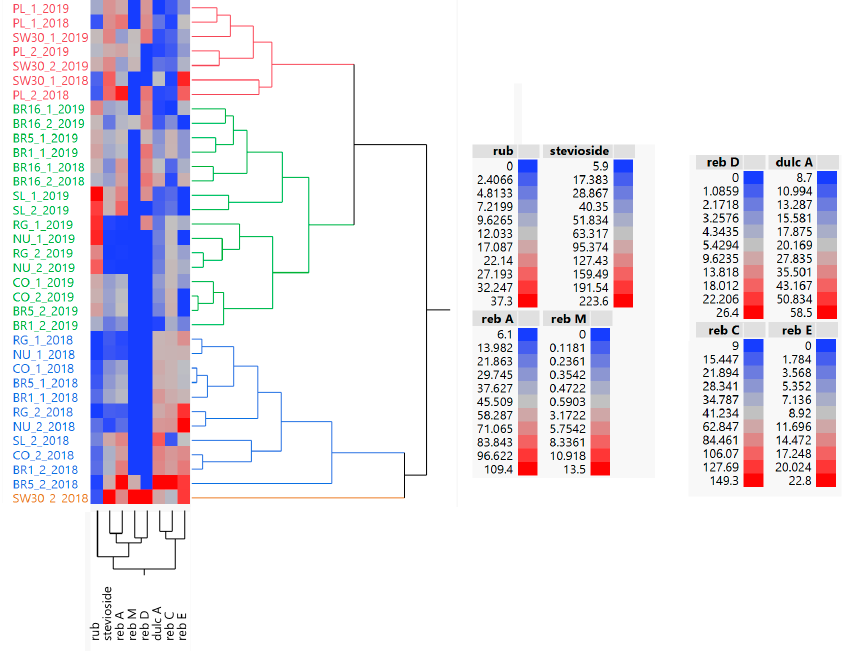
Figure 4. Hierarchical cluster analysis (HCA) on SVglys profile (Rub, Dulc A, Stev, Reb A, C, D, E, and M). Each genotype is followed by the indication of harvest time (1 = first harvest; 2 = second harvest) and crop age (2018 and 2019).